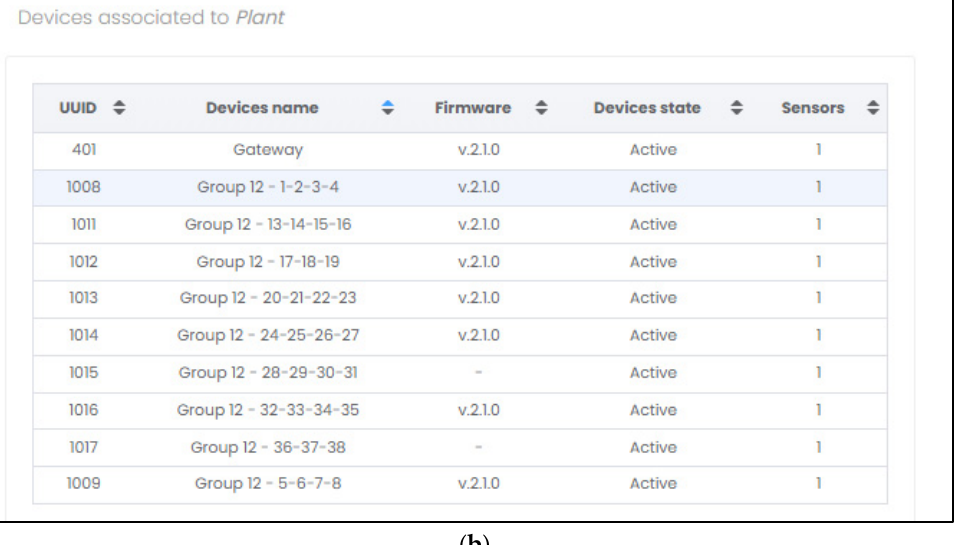
Figure 6. Graphical interface: ( a ) Plant location. ( b ) Detail of deployed nodes.